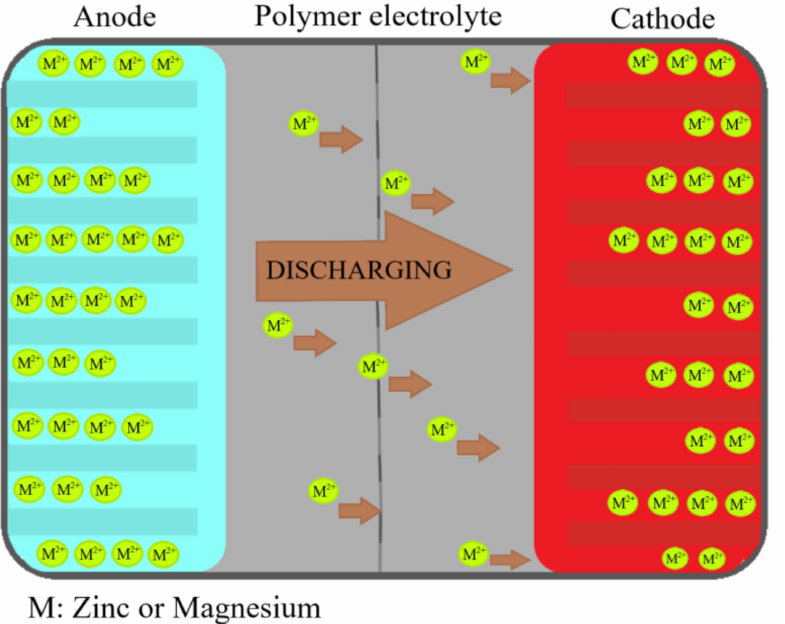
Figure 1. Schematic diagram of Zn-ion and Mg-ion battery discharge. Reproduced with permission from Renew. Sustain. Energy Rev., 65, Singh et al., Perspectives for solid biopolymer electrolytes in dye sensitized solar cell and battery application, 1098–1117, 2016